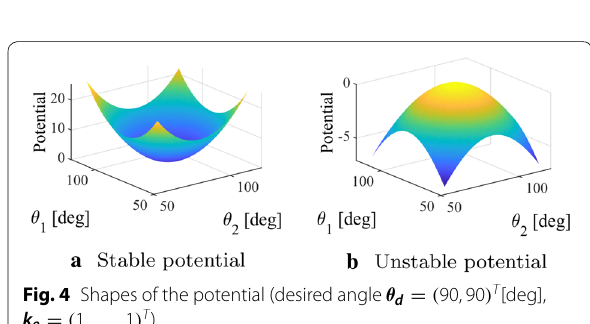
Fig. 4 Shapes of the potential (desired angle θ d k e ( 1, ... ,1 ) T =